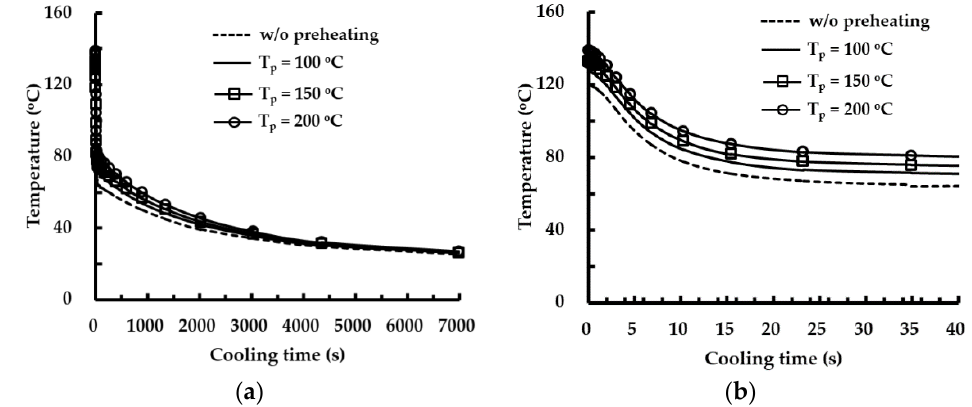
Figure 20. Cooling time–temperature curves for different preheating temperatures: ( a ) cooling time–temperature curves for total cooling time; ( b ) cooling time–temperature curves up to 40 s.